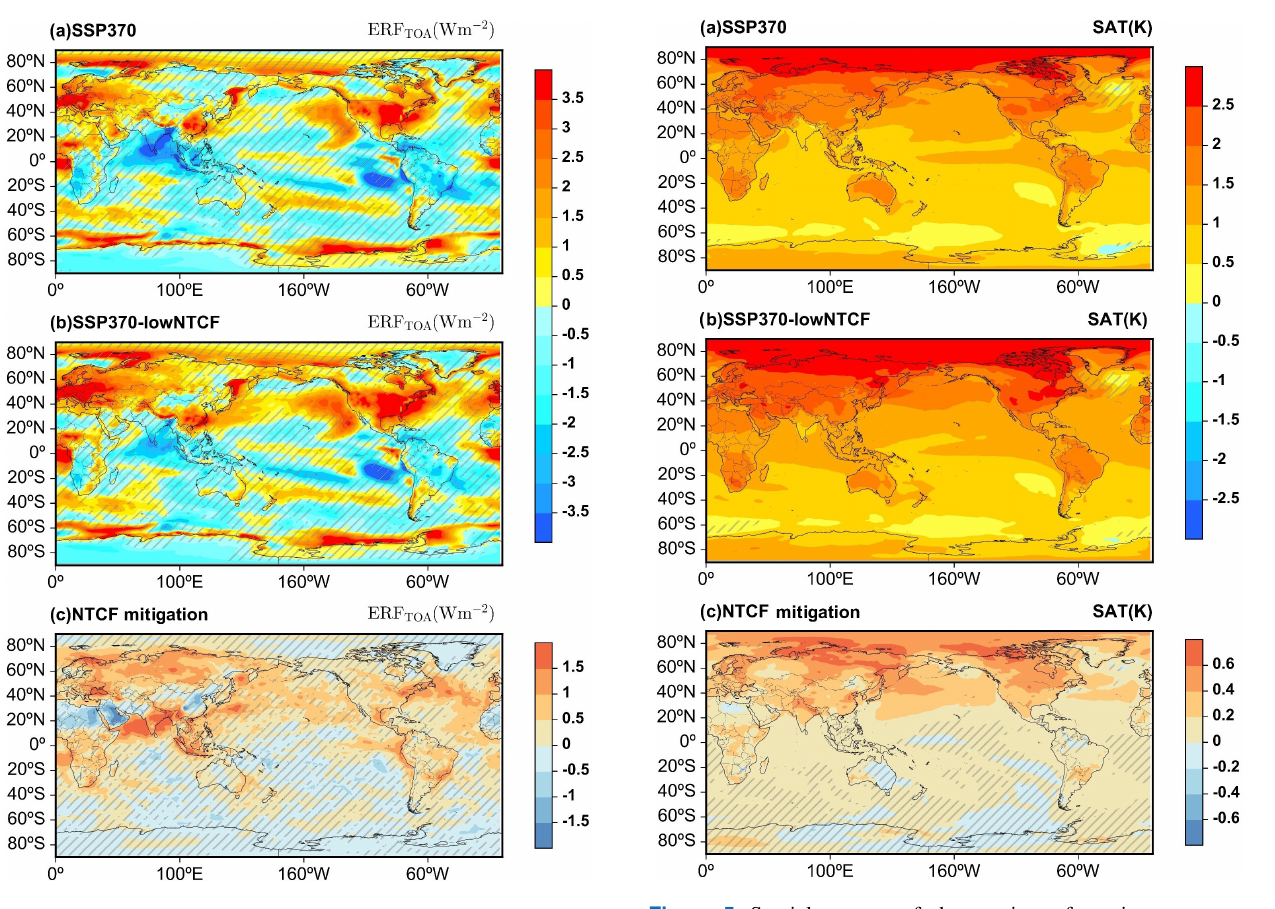
Figure 4. Spatial patterns of effective radiative forcing (ERF) at top of atmosphere (ERF TOA ) during 2031–2050 under the (a) SSP3- 7.0 and (b) SSP3-7.0-lowNTCF scenarios and (c) ERF only caused by the non-methane SLCF reductions relative to 1995–2014 (units: Wm − 2 ). The areas with hatching indicate that at least one out of seven models disagrees on the sign.